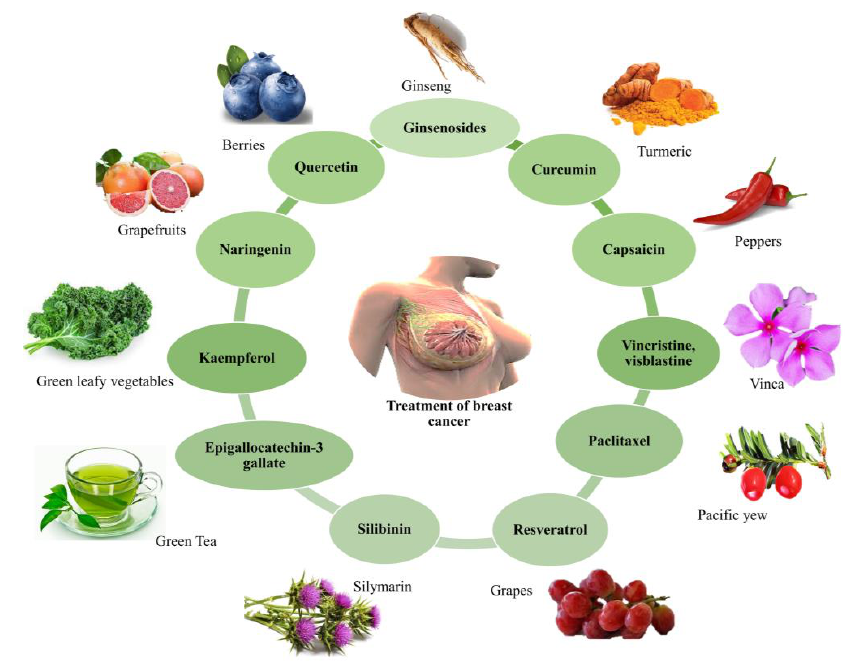
Figure 2. The role of various phytochemicals in the treatment of breast cancer.